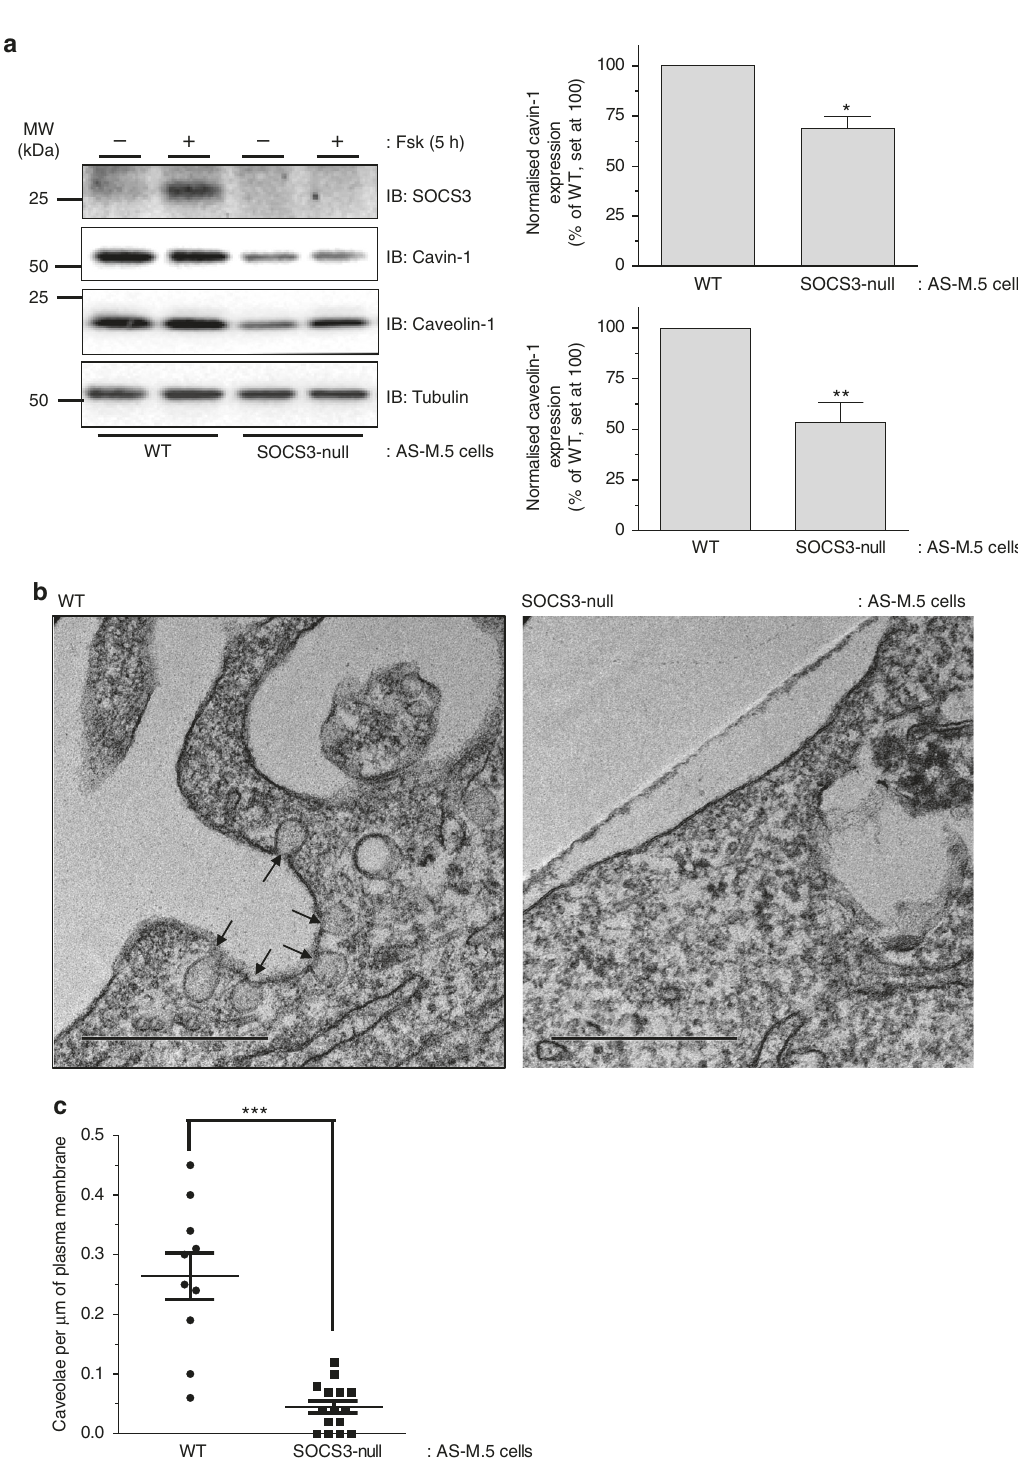
Fig. 2 Effect of SOCS3 deletion on caveola abundance in endothelial cells. a Upper: Detergent-soluble whole-cell lysates from WT and SOCS3-null AS-M.5 human angiosarcoma-derived ECs treated with either vehicle or 50 μ M Fsk for 5 h were equalised for protein content for SDS-PAGE for immunoblotting with the indicated antibodies. Lower : Quantitation of cavin-1 and caveolin-1 protein levels in unstimulated AS-M.5 cells is presented as mean ± standard error for N = 3 experiments. * P < 0.05, ** P < 0.01 vs. WT cells. b Transmitting electron microscopy (TEM) was performed on WT and SOCS3-null AS-M.5 cells as indicated. Cell surface caveolae (indicated by the arrows) were readily detectable in WT cells (left panel). In contrast, plasma membranes from SOCS3-null cells were fl at and caveolae density was signi fi cantly reduced compared to WT cells (right panel). Scale bar = 0.5 μ m. c Quantitation of caveola density (number of caveolae per μ m of plasma membrane) in WT and SOCS3-null AS-M.5 cells. *** P < 0.0001 vs. WT